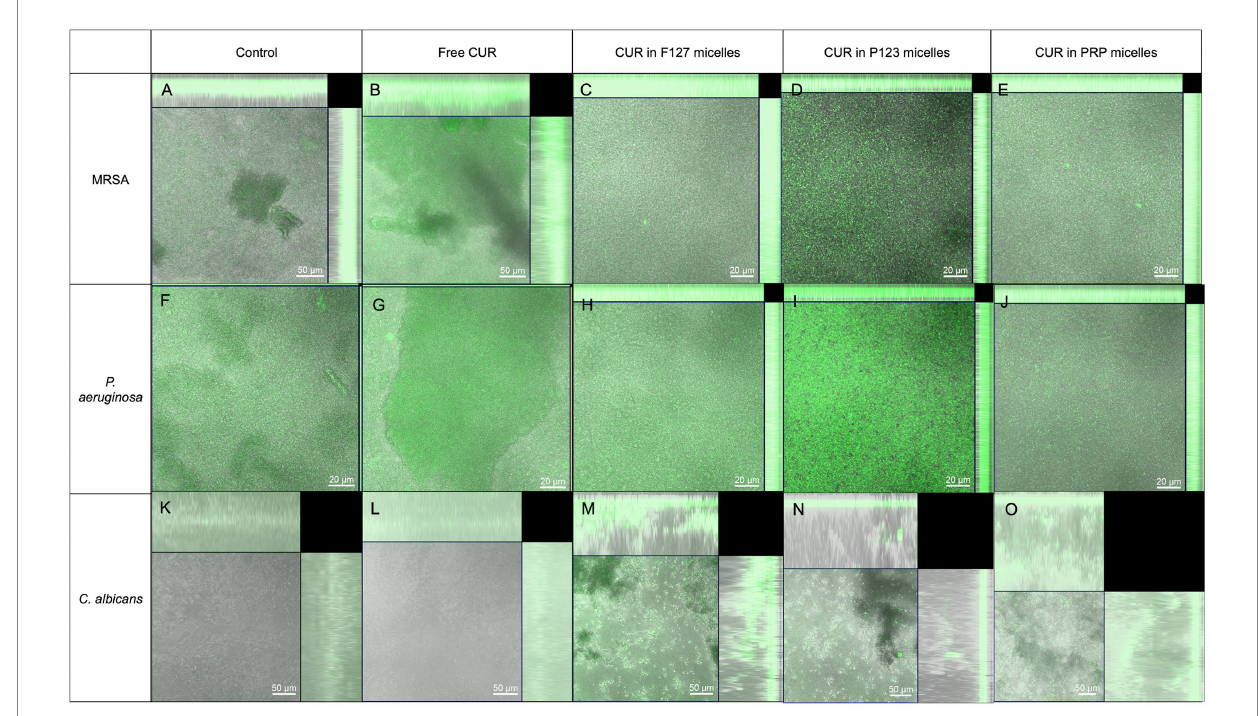
FIGURE 10 Confocal microscopy images showing the fluorescence of biofilms incubated only with the culture media [controls (A,F,K) or CUR in its free form (B,G,L) ] or loaded into the micelles (F127 in C,H,M ; P123 in D,I,N ; and PRP in E,J,O ) by the biofilms of MRSA (A–E) , P. aeruginosa (F–J) , and C. albicans (K–O) . Images are overlap of bright field and fluorescence